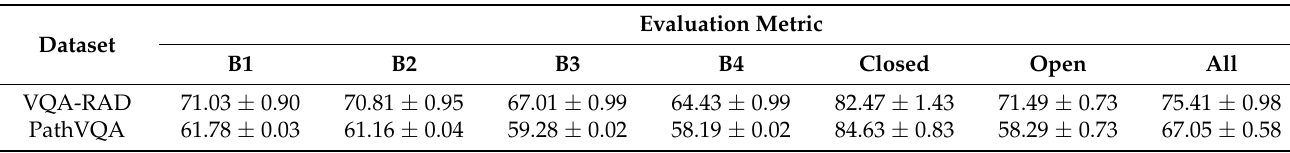
Table 2. BLEU-1, 2, 3, 4, closed-ended, open-ended, and overall accuracies.